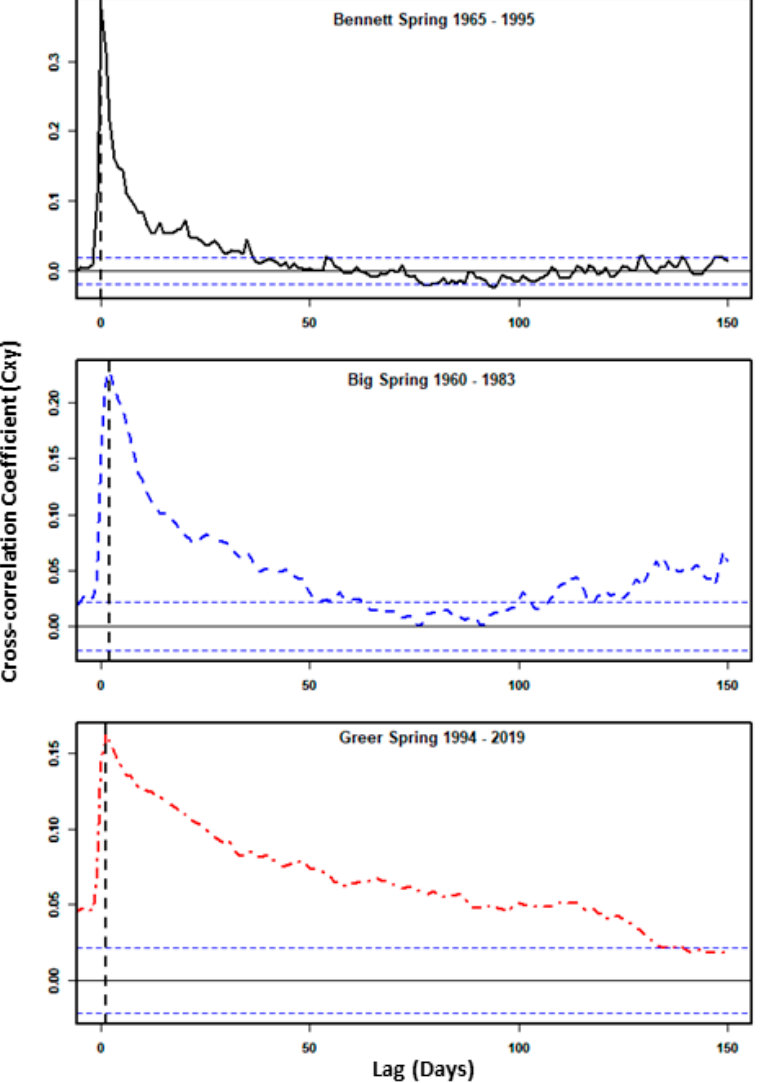
Figure 8. Cross-correlation plots for rainfall at adjoining stations and discharge at the studied springs for different time intervals. The horizontal blue dashed lines represent the statistical significance at 95% of confidence intervals.